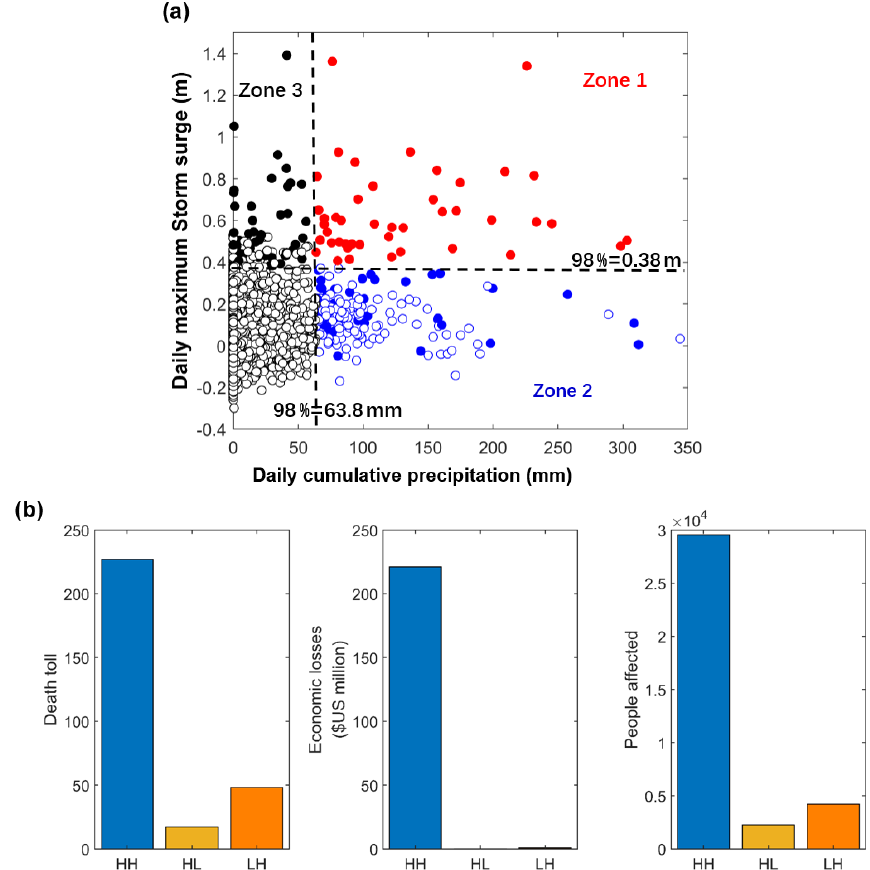
Figure 9. (a) Daily maximum storm surge plotted against daily cumulative precipitation for threshold of 98% for Hong Kong. Filled dots indicate events linked to TC historical damage records. (b) Damages by joint occurrences (HH: high storm surge and high precipitation) flood and events where only one flood driver was extreme (HL refers to high storm surge and low precipitation; LH refers to low storm surge and high precipitation) in Hong